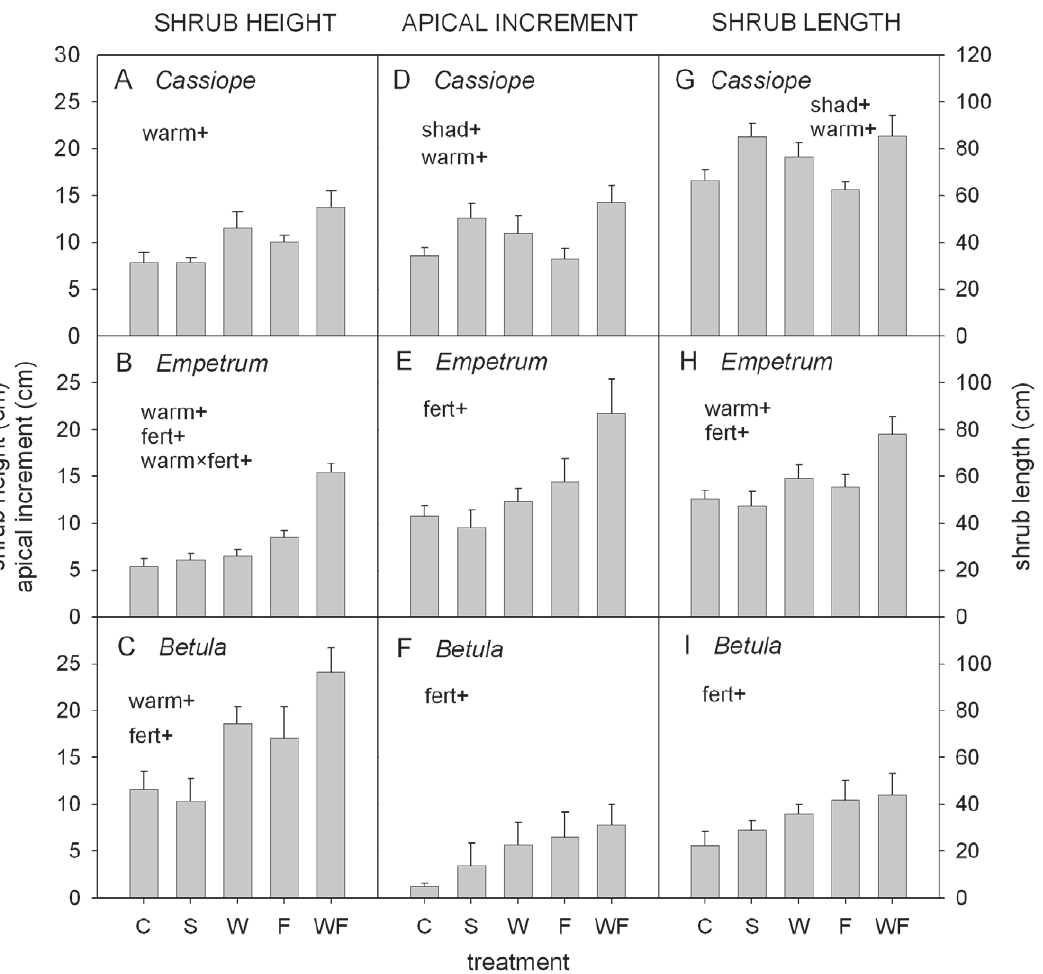
Figure 2. Shrub height, shrub length and apical (current year’s stem) increment of subarctic shrubs in manipulated environment. Values (mean + 1SE; n=5–6) of shrub height (left panels), apical increment (central panels) and shrub length (right panel) of three subarctic heath shrubs ( Cassiope tetragona , Empetrum hermaphroditum and Betula nana ) in Abisko (Northern Sweden) subjected to 22 years of environmental manipulation (shading S, warming W, fertilisation F, combined warming plus fertilisation WF) against the control (C). The environmental factors significantly affecting growth are reported on the upper part of each panel (shad: shading; warm: warming; fert: fertilisation, and warm 6 fert: warming 6 fertilisation) with the symbols + and 2 indicating the direction of the response (positive and negative, respectively).